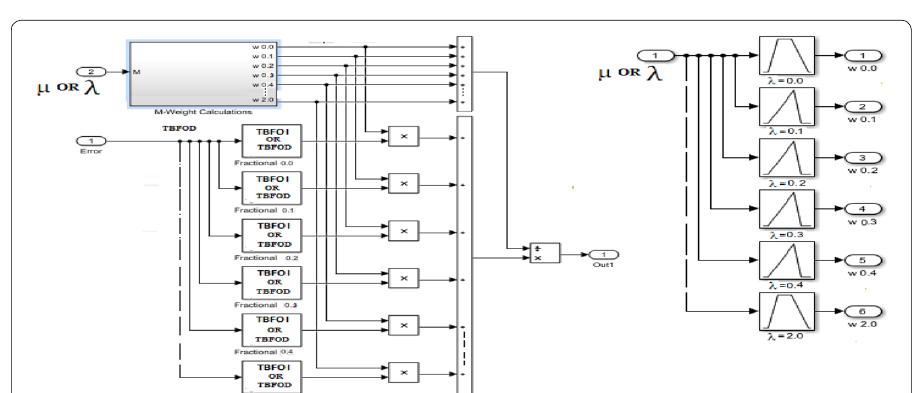
Fig. 8 Block diagram of the fractional orders of the integral and